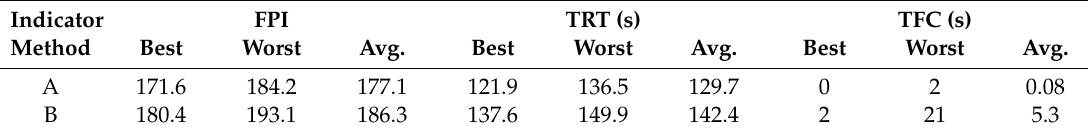
Table 3. Statistical indexes for both